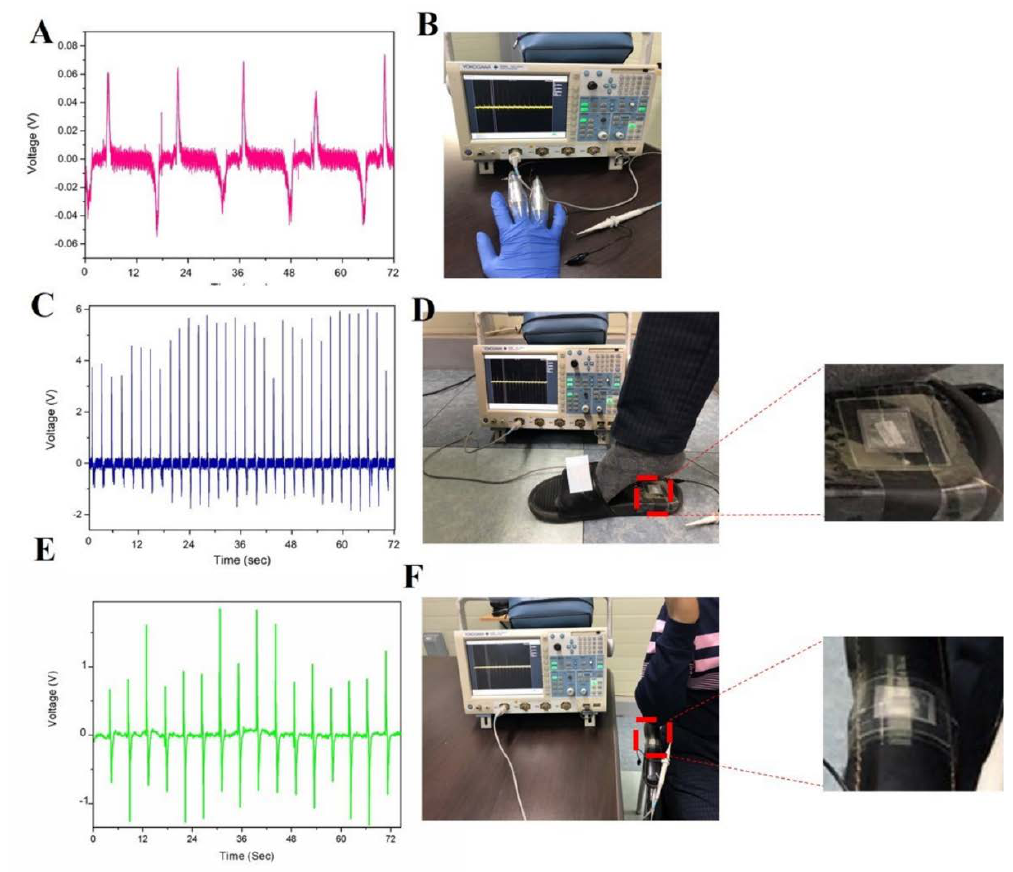
Figure 6. Biomechanical piezoelectric sensors studies: Piezoelectric output voltage and photograph of PGANF FENG as ( A , B ) Bio E-Skin, ( C , D ) locomotion detector, ( E , F ) smart chair.